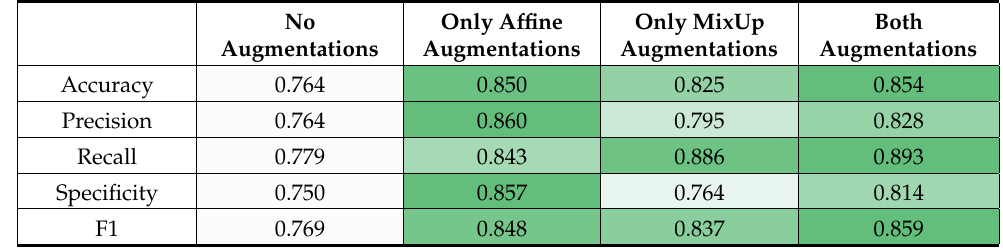
Figure 8. Blind testing performance for Top 3 categorical ensemble bagging across four different data augmentation strategies for ShrapML. Average confusion matrices are shown for two blind test image sets for ( A ) no augmentation, ( B ) affine augmentation only, ( C ) MixUp augmentation only, ( D ) both affine and MixUp augmentations. A total of 70 shrapnel and 70 baseline images were used for each blind test run. Table 4. Performance metrics for Top 3 categorical ensemble bagging across four different data augmentation strategies for ShrapML. Mean results for two separate blind test subjects are presented. Heat map overlay is set between the minimum and maximum value for each performance